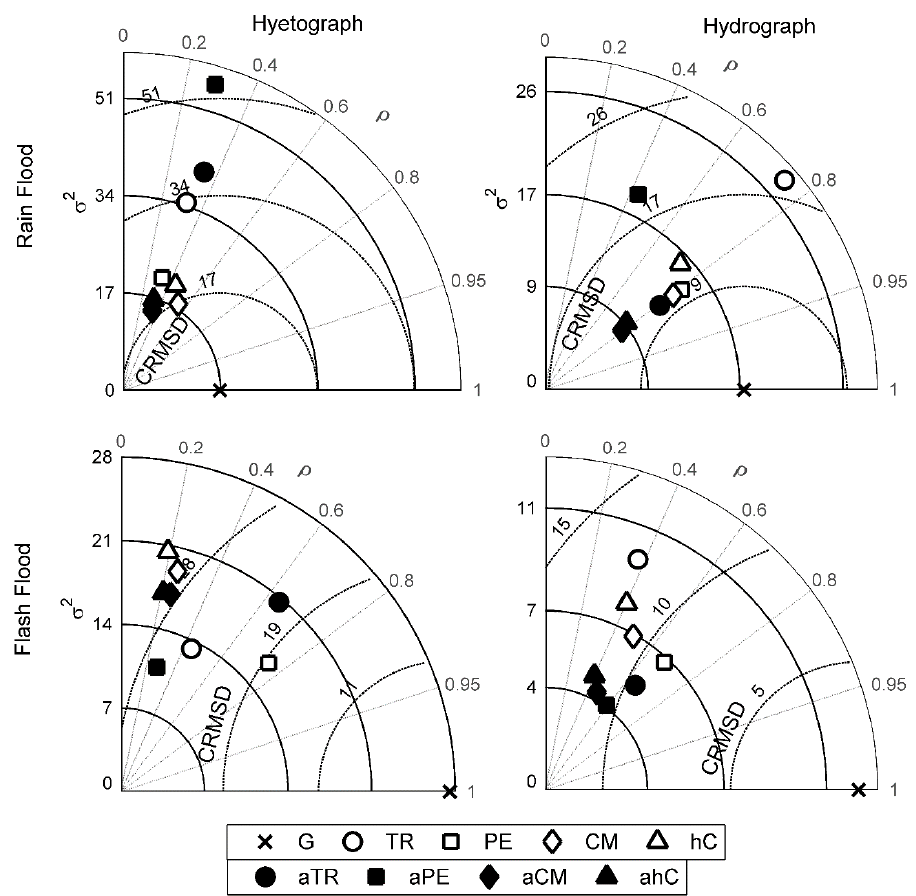
Figure 3. Taylor diagram of the cumulative rainfall and flow depths for different products.